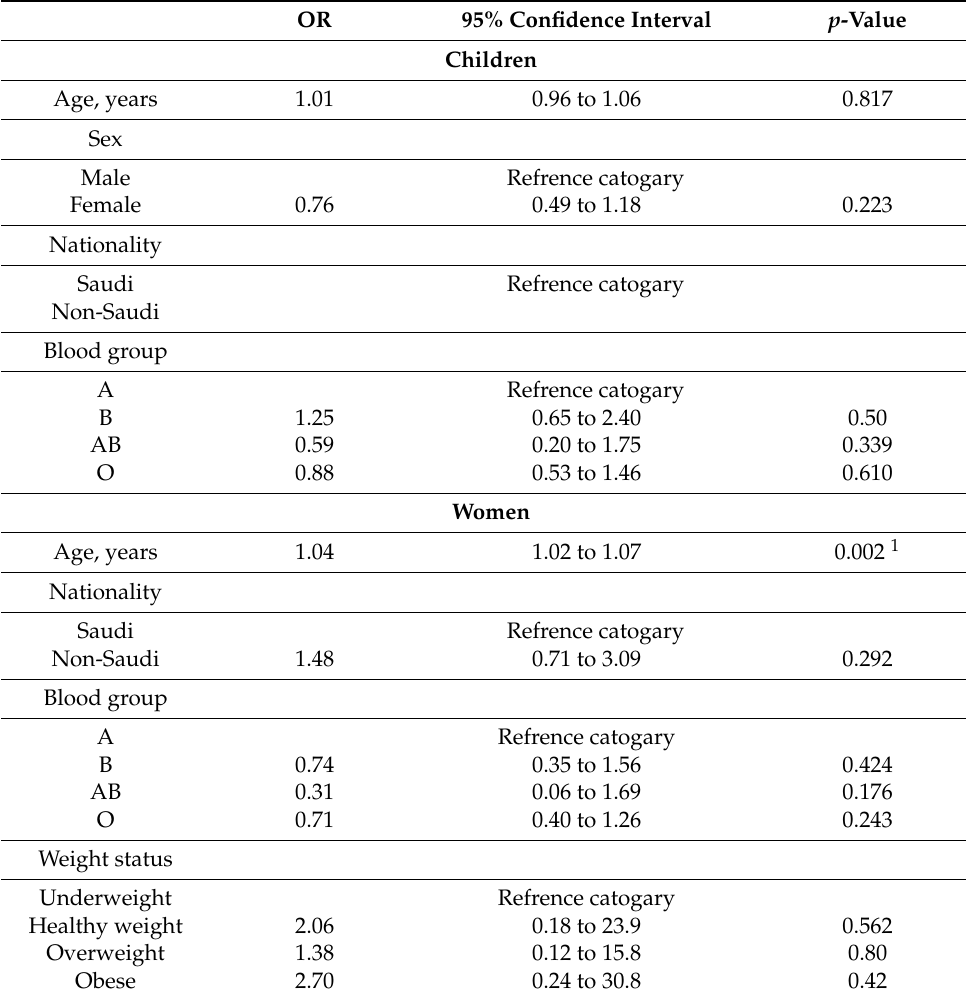
Table 3. Logistic regression analysis of SARS-CoV-2 anti-S IgG antibody status and participants’ characteristics ( n =